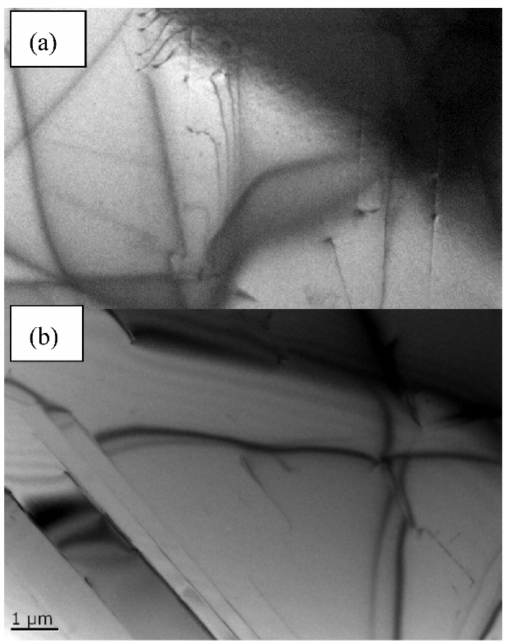
Figure 5. TEM images of Fe–Mn–Cr–CN TWIP steels: ( a ) 12CrN; and ( b )